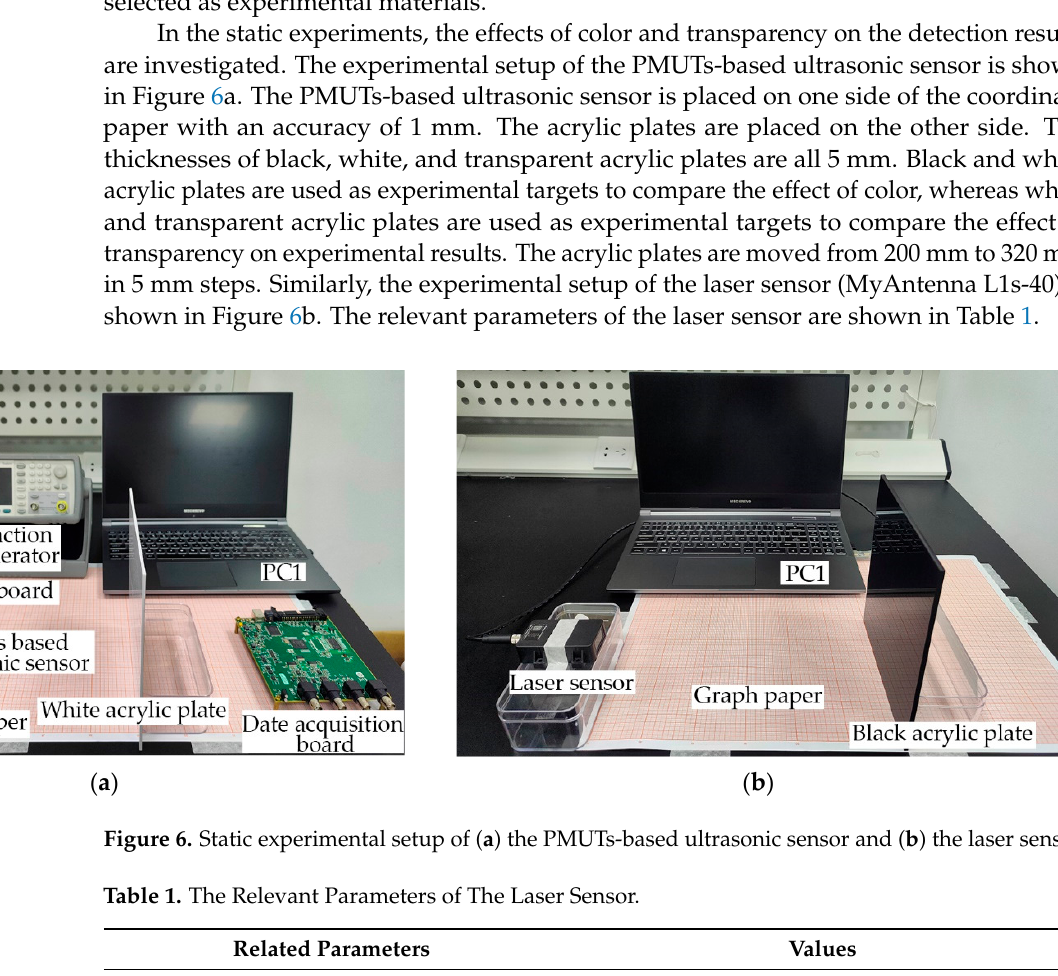
Figure 5. The ultrasonic target detection system in cooperation with a robotic manipulator.